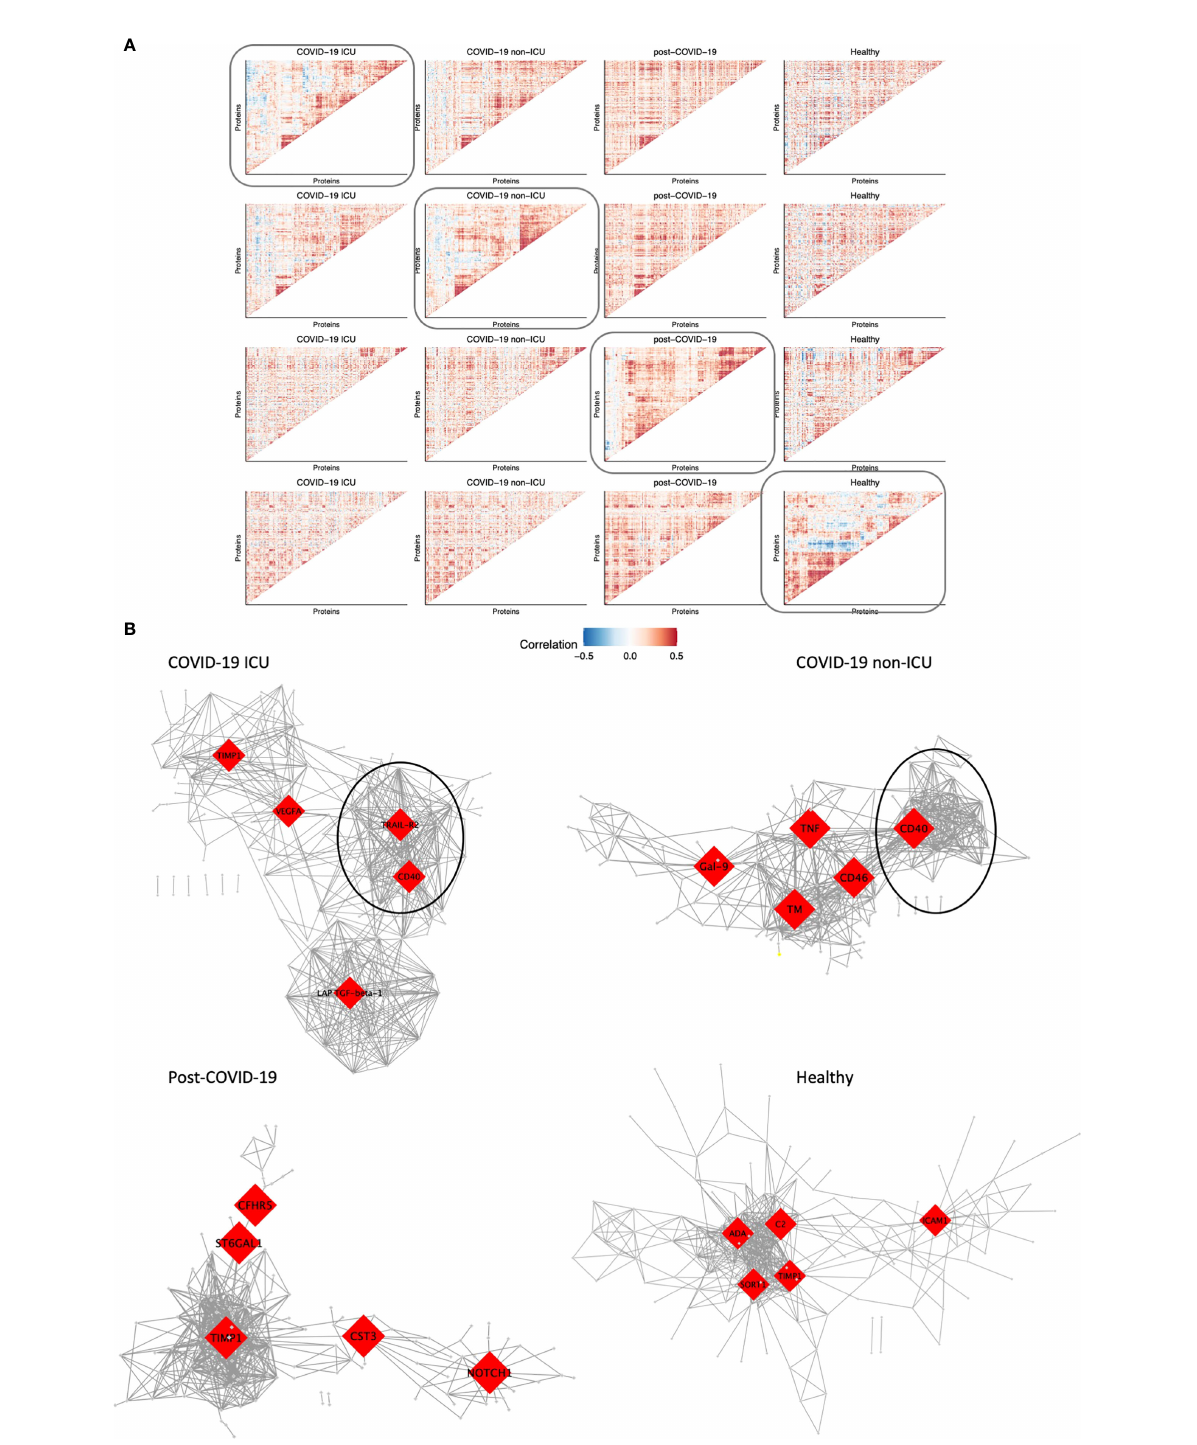
FIGURE 5 Modules of co-expressed proteins change over conditions. (A) Visualization of modules of co-expressed proteins per condition. Protein-protein correlations were calculated for each condition separately. Hierarchical clustering was performed on the matrix of correlation values for one condition as indicated by the box. The same protein order was kept for all heatmaps in the same row to visualize how modules change over condition relative to one condition. This was performed systematically for all four conditions: COVID-19 ICU, non-ICU, post-COVID-19, and healthy individuals. (B) Co-expression network of each condition. The top fi ve hub genes for each network are highlighted in red. Only the top 2.5% highest correlated connections are shown, corresponding to 576